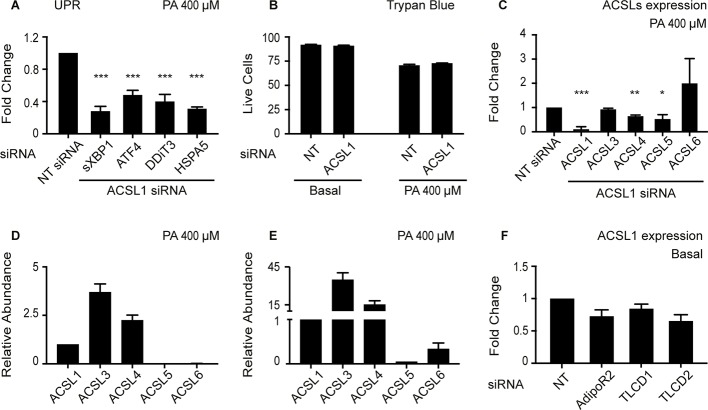
Effect of ACSL1 silencing on UPR activation, viability, and expression of other ACSLs.(A) Relative expression levels measured using qPCR of several UPR markers in HEK293 cells challenged with 400 μM palmitate (PA) and treated with either non-target (NT) or ACSL1 siRNA. (B) Viability measured using the Trypan blue staining method of HEK293 cells in basal media or challenged with 400 μM PA and treated with either NT or ACSL1 siRNA. (C) Relative expression levels measured using qPCR of several ACSLs in HEK293 cells challenged with 400 μM PA and treated with either NT or ACSL1 siRNA. (D–E) Relative expression levels of ACSLs measured using qPCR in HEK293 cells cultivated in basal media and treated with either NT (D) or ACSL1 siRNA (E) against the indicated genes. (F) Change in ACSL1 expression levels in HEK293 cells cultivates din basal media and treated with siRNA against the indicated targets. Statistically significant differences of interest are indicated, where *: p<0.05, **: p<0.01 and ***: p<0.001.